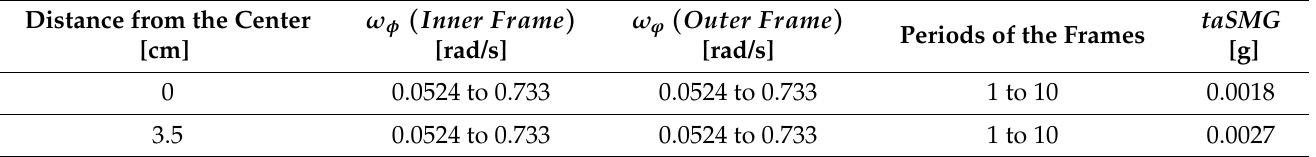
Table 2. Rotational parameters in random